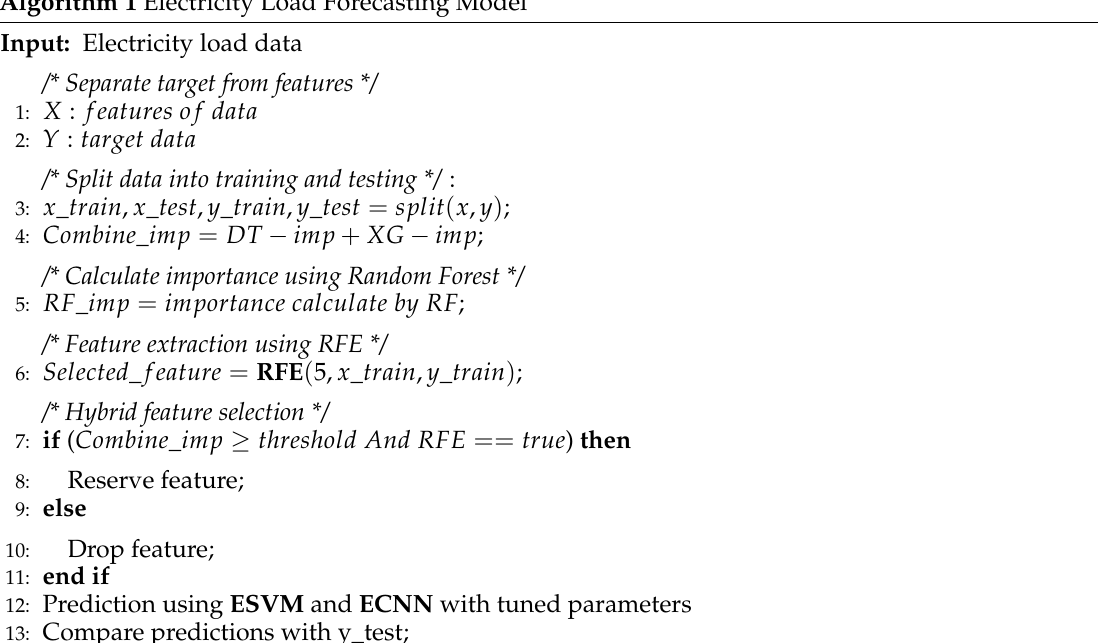
Algorithm 1 Electricity Load Forecasting